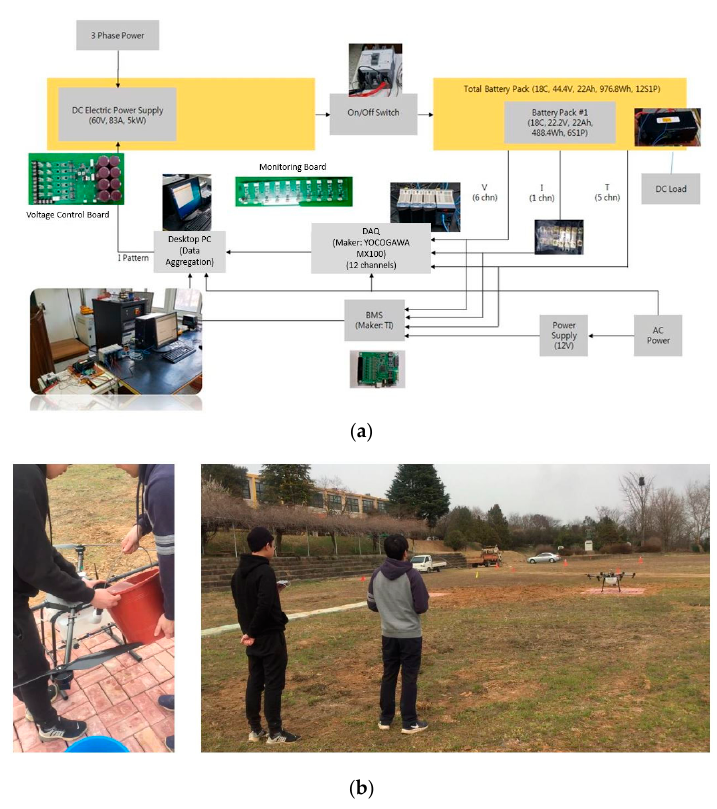
Figure 5. Test environments: ( a ) indoors; and ( b ) outdoors.